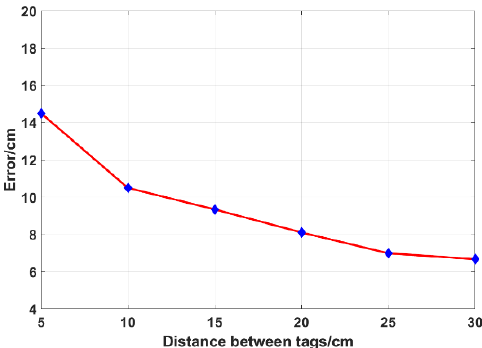
Figure 18. Distance between tags vs. Error.